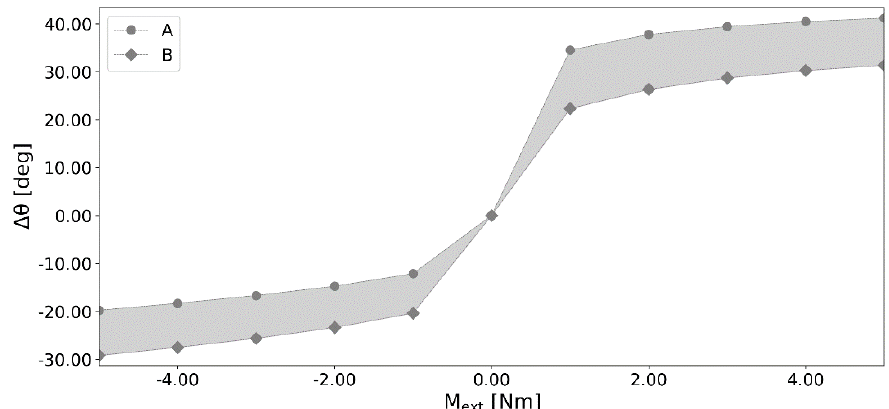
Figure 7. Angular displacement Δ θ i versus the external moment M ext for the two most different adversarial structures A and B . Table 2. Maximal angular displacement Δ θ i in plantarflexion and dorsiflexion for the two most different adversarial structures A and B